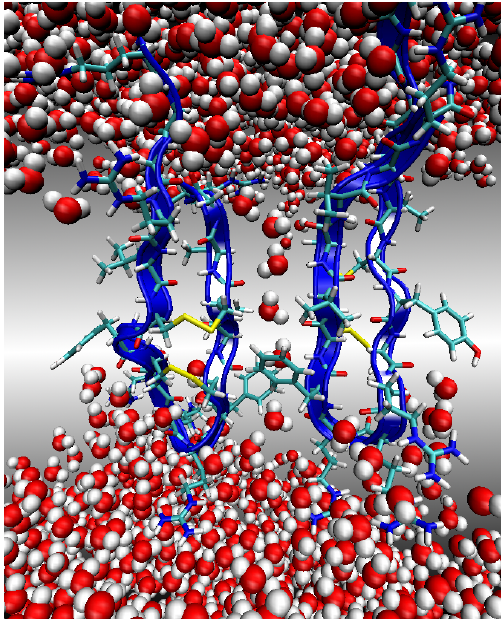
Figure 2. A snapshot at the end of a 4 ns simulation of the PG1 dimer in the parallel β -sheet arrangement inside the membrane. Peptides are shown in blue NewCartoon representation. Water is shown as van der Waals spheres. The solution Na + and Cl − counterions are shown as small yellow and large green spheres, respectively. The peptide Cys and Arg residues are shown as sticks. The sidechain atoms of the other residues and the bilayer lipid atoms are omitted for